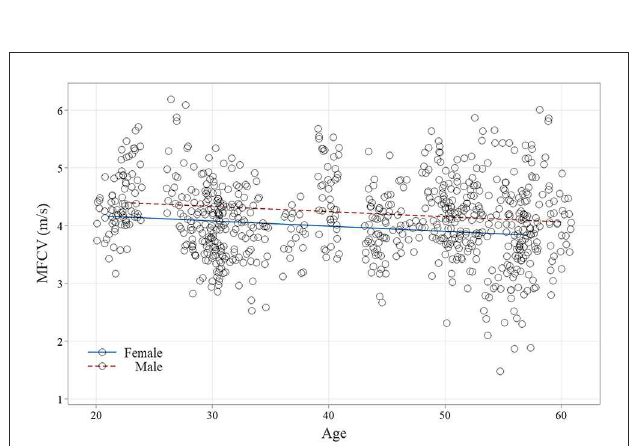
FIGURE7 Scatterplot of the muscle fiber conduction velocity (MFCV) from 784 muscle fiber action potentials (female subjects, 269 and male subjects, 415) is displayed throughout the age. Note that both sex lines had a small R-Sq and ran in parallel, maintaining the faster velocity in male subjects throughout the